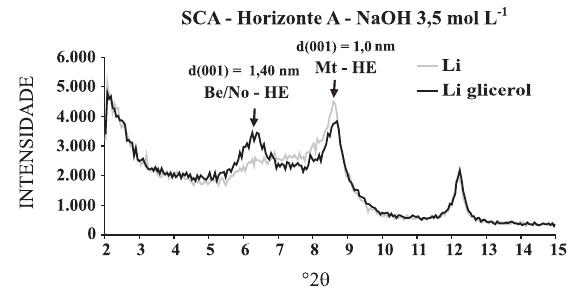
Figura 8. Difratogramas de raios X de amostras orientadas de argila desferrificada e tratada com solução de NaOH 3,5 mol L -1 do horizonte A do perfil do Setor de Ciências Agrárias (SCA) da UFPR, submetidas ao teste de